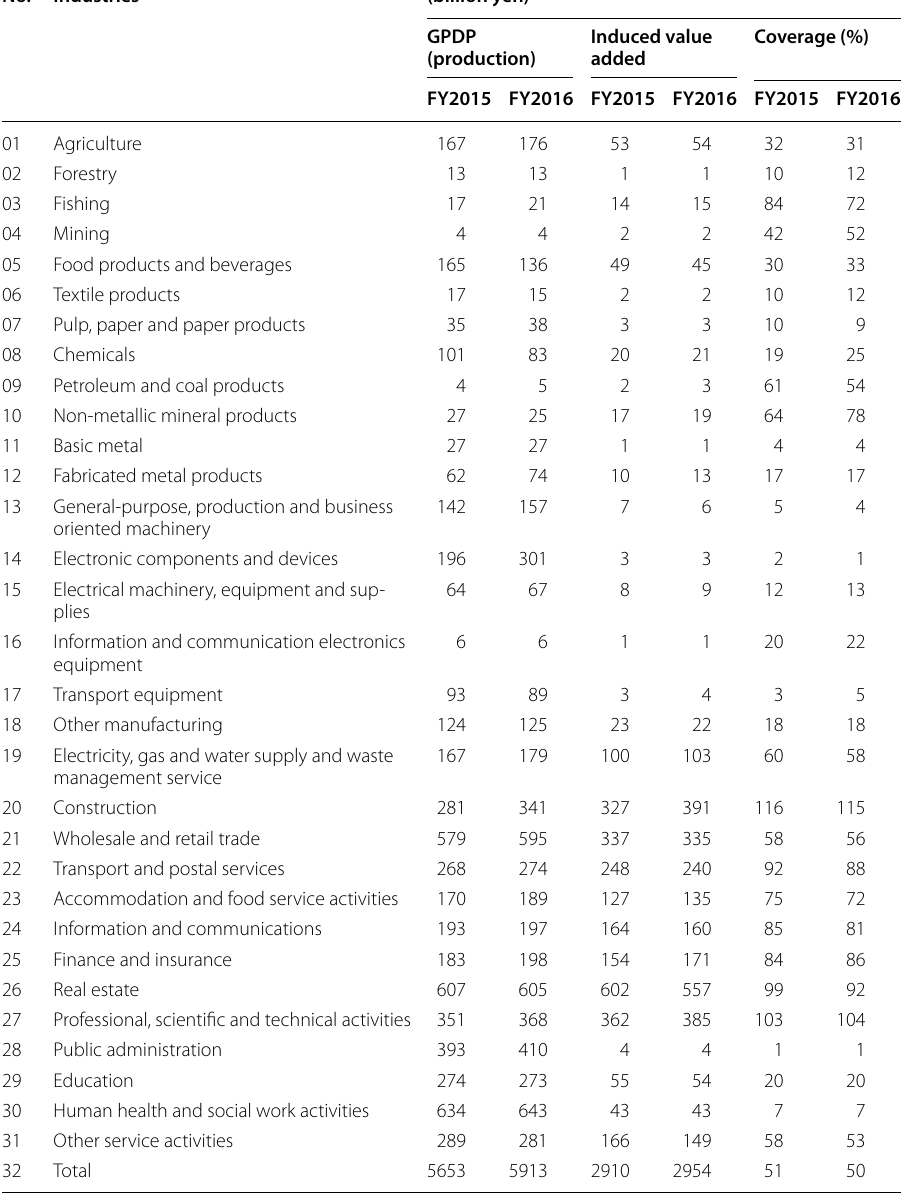
Table 7 Annual cumulative induced value-added coverage to